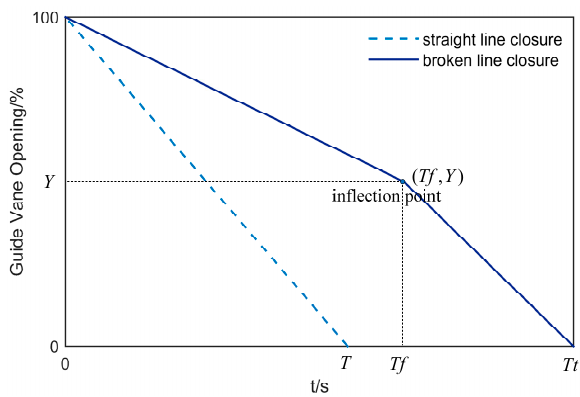
Figure 6. Schematic diagram of the straight line closure and the broken line closure.